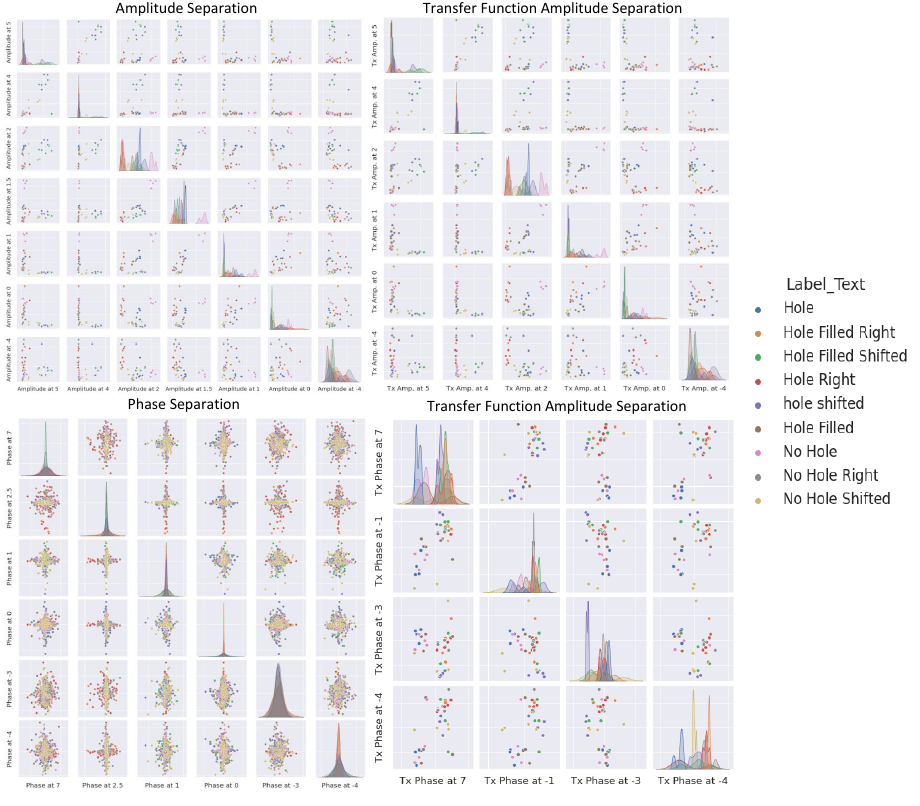
Figure 22. The separation matrices for the Amplitude data ( top left ), the Transfer Function Amplitude data ( top right ), the Phase data ( bottom left ), and the Transfer Function Phase data ( bottom right